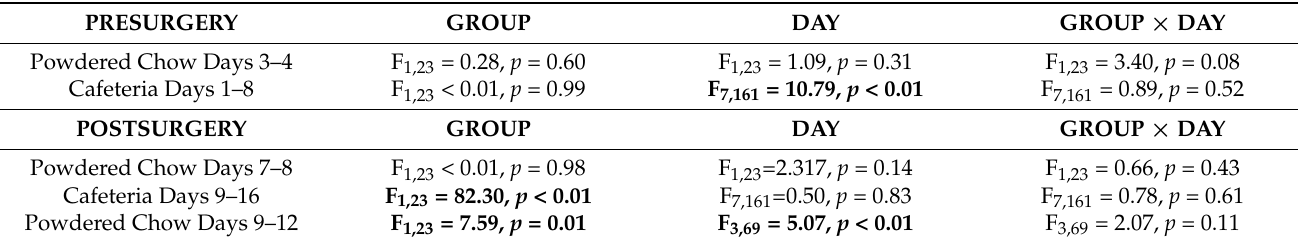
Figure 3. Daily Energy Intake across All 22-h Periods during Meal Pattern Monitoring. Mean ( ± SE) for CTL rats (combined SHAM and IRON groups, n = 14; orange circles) and RYGB ( n = 11; blue triangles) rats for powdered chow days (PC), acclimation days for each food (Acclim.; CF: chickpea flour; Y: yogurt; PB: peanut butter; SFW: sugar/fat whip), and cafeteria diet days. Dashed vertical lines indicate transitions between diet conditions (thin dashed) and between pre- and postsurgical phases (thick dashed). Statistically significant results from two-way mixed ANOVAs (Table 2) are indicated by horizontal lines: Gray solid (group), dark gray solid (day), or gray dashed (group × day interaction). *: Statistically significant result of a paired t -test for the group indicated by color, comparing the marked day to the previous day (Table 3). Table 2. Two-way ANOVAs Comparing Total Energy Intake between Groups for Each Diet Condition.